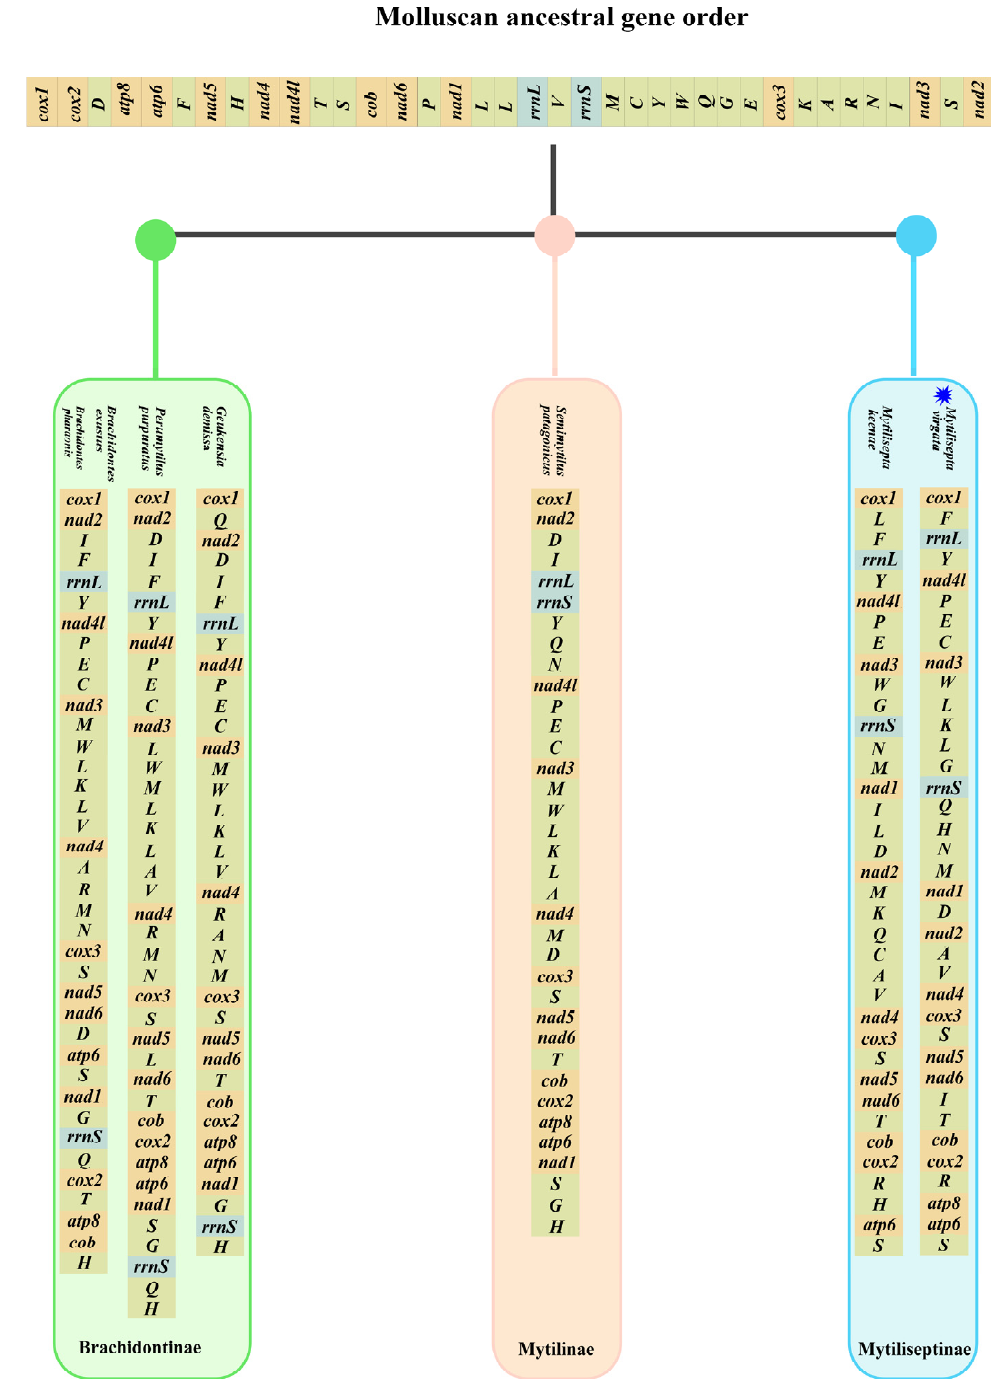
Figure 6. Comparison of mitochondrial gene rearrangements between the M. virgata and Molluscan ancestral gene orders. Gene segments are not drawn to scale. The blue symbol indicates the specie of this study.